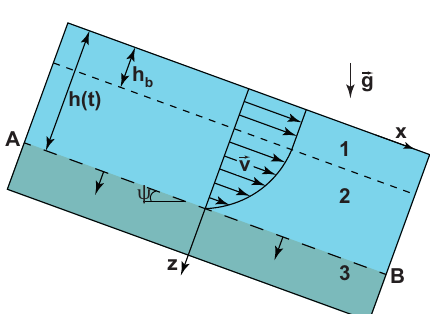
Figure 12. Scheme of the flow and the coordinate system. The origin is located at the upper surface, x -axis is directed along the slope, z -axis is normal to the upper surface of the flow and directed to the bottom. For fluid with the yield stress, there is a plug layer 1 adjacent to the open boundary, its thickness is h b . Layer 2 is the shear